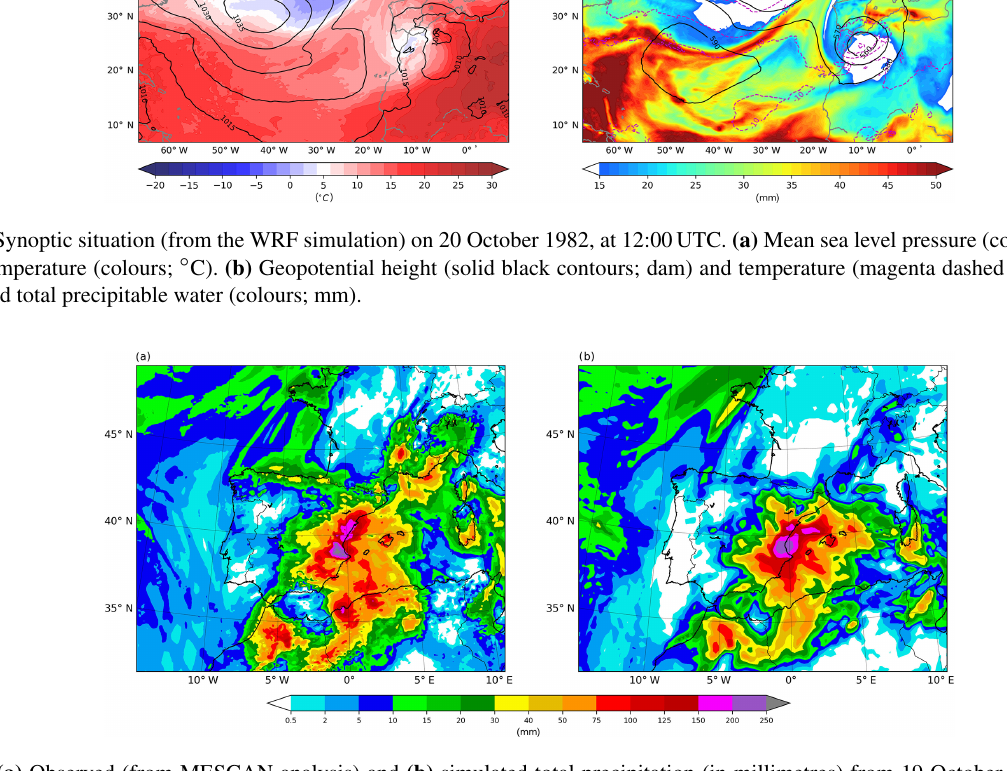
Figure 4. (a) Observed (from MESCAN analysis) and (b) simulated total precipitation (in millimetres) from 19 October at 06:00UTC to 22 October at